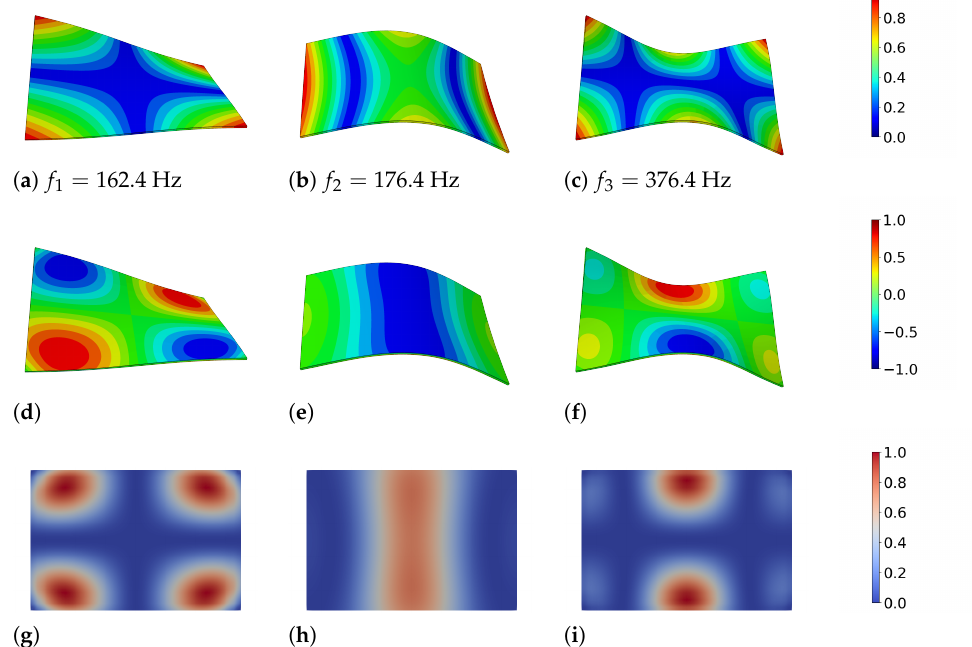
Figure 4. ( a – c ) Mode shapes of the rectangular aluminum plate 300 mm × 200 mm × 3 mm, deflection normalized to 1. ( d – f ) Distribution of hydrostatic pressure at the surface of the plate, σ kk = σ xx + σ yy + σ zz . ( g – i ) Spatial distribution of the dissipated energy, Q , in the first three eigen- modes of the plate at time T /4. A cut at mid-plane level of the plate is displayed. The values were normalized to 1 with respect to the maximum in each mode since they were based on relative displacements and temperature